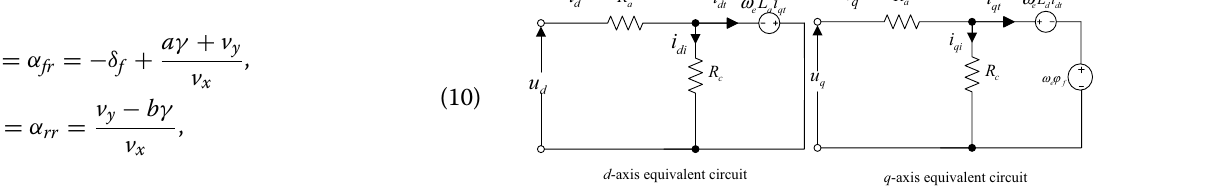
Figure 3 D-q equivalent circuit of a